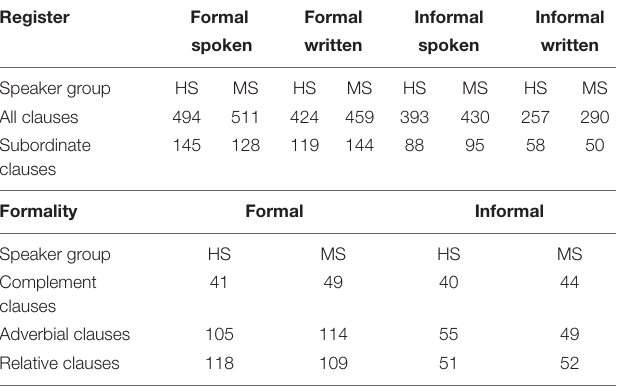
TABLE 1 | English clause productions by speaker group and register/formality.